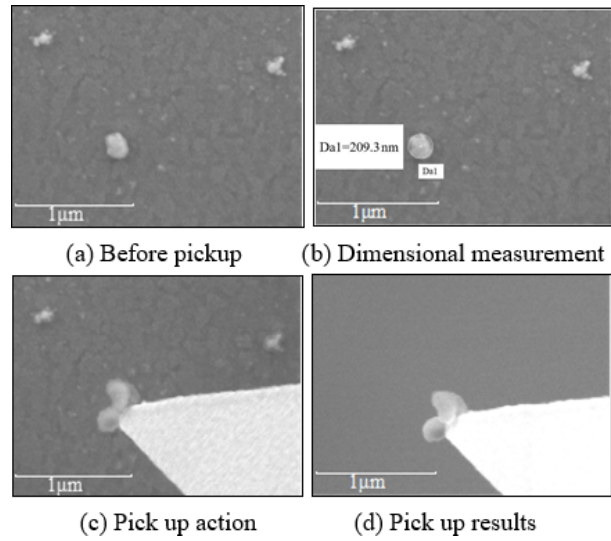
Figure 9. Nanocluster particles picked up on ITO substrate.